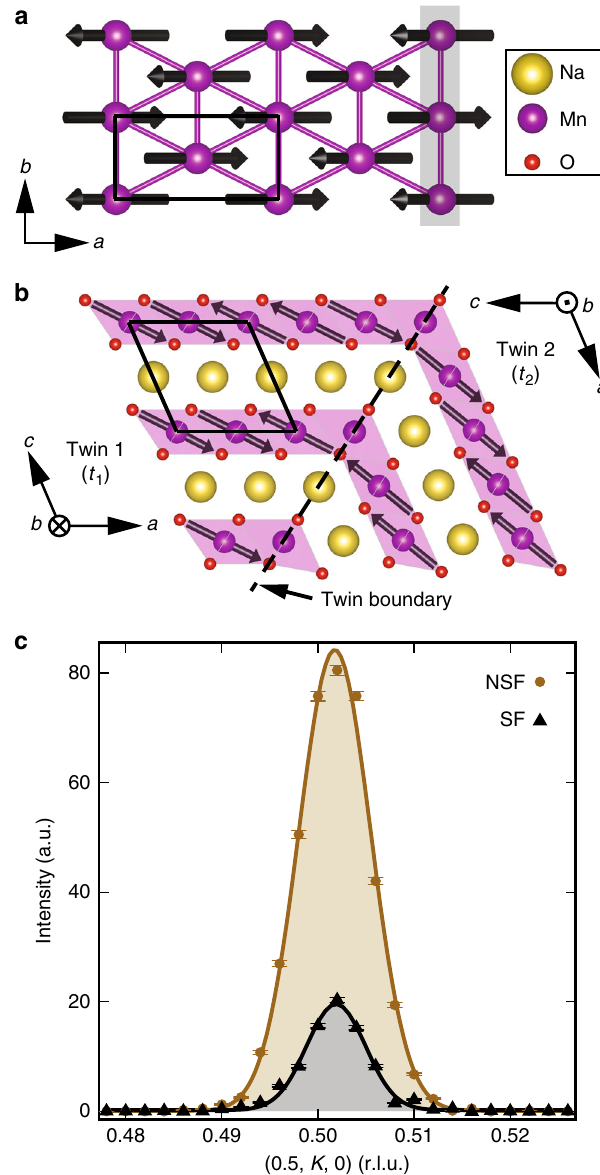
Fig. 1 Summary of the crystal and magnetic structures of α -NaMnO 2 . a Projection of the 3D magnetically ordered state onto the ab -plane. The black rectangle denotes the chemical unit cell. The gray shaded region highlights the chain direction between nearest neighbor Mn atoms. b Moments in the ac -plane, as well as the intergrowth of two twin domains. The black rhombus again denotes the chemical unit cell. Polarized elastic neutron data at the antiferromagnetic zone center in c con fi rm the orientation of the magnetic moments within the ordered state ( T = 2.5 K) as previously reported. The shaded regions are the Gaussian fi ts of the non spin- fl ip (NSF) and spin- fl ip (SF) channels, which were used to determine the moment orientation. The neutron polarization P is perpendicular to the scattering vector and parallel to the c -axis in this con fi guration. Error bars represent one standard